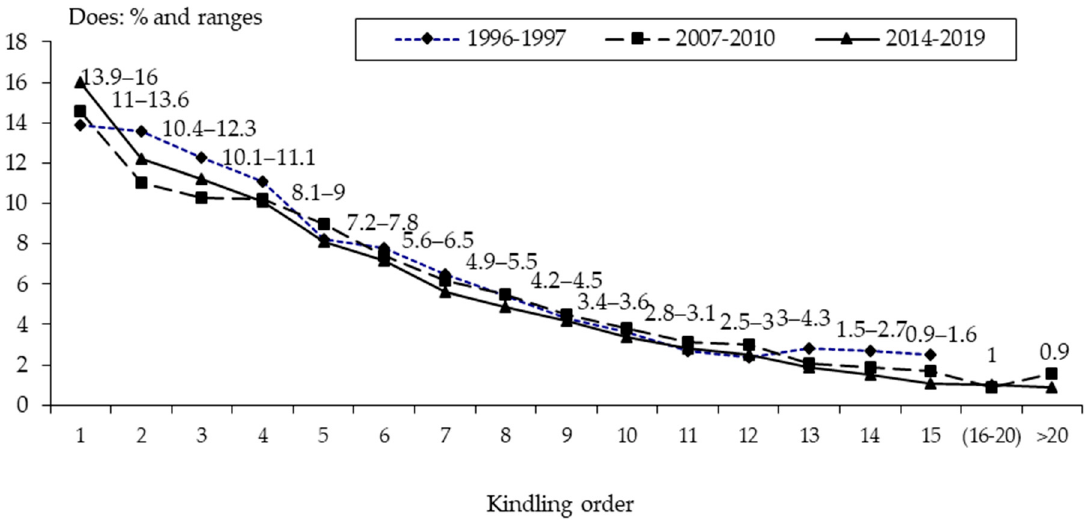
Figure 1. Descriptive age traits of 48,162 female rabbits, based on 10,422 examined does on 168 farms from 1996 to 1997 (… ♦ ...). In addition, there were 20,985 does checked on 129 farms from 2007 to 2010 (… ■ …), and 16,755 does on 132 farms from 2014 to 2019 (… ▲ …). Data derived from Rosell and de la Fuente [20], Sánchez et al. [6], and the current study, respectively.